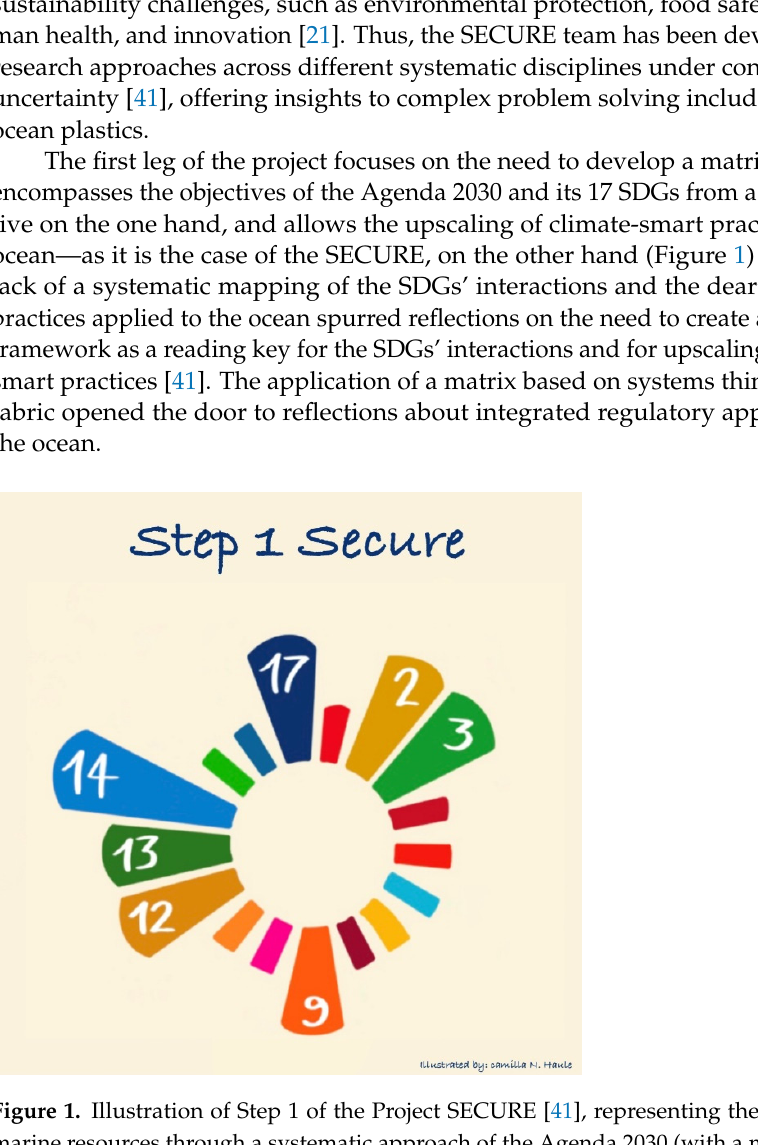
Figure 2. A case study relevant to the EU food on the integral ecology approach to food novelty applied to seaweed (frame of the illustration) through the lens of the systematic approach to the Agenda 2030 [42]. Illustration for SECURE by Camilla Neema Haule 2021. The integral approach suggested by IE offers further insights into the complex problems and the uncertainties posed by plastics at sea, laying the foundation for systematic and integrated regulation. Construing the issue of plastic pollution through the lens of IE redefines the health of the ecosystem as the health of all beings, unlocking solutions in all those cases where the risks posed by plastics to food security and health are not yet proved beyond doubt. Grounded on the precautionary principle, a systematic and integrated regulation of plastic pollution at sea is justified by the need to prevent potential harms to the human rights to a healthy environment [43], healthy food, and to